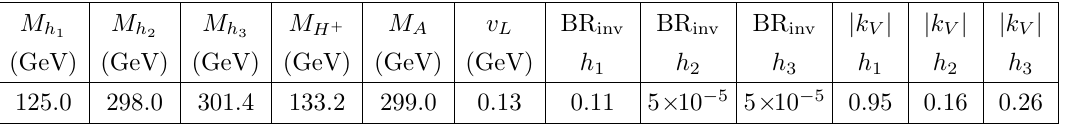
Figure 8 . Left panel: BR inv ( h 3 ) versus BR inv ( h 2 ). Right panel: the e(cid:11)ective couplings to vector bosons with respect to that of the SM, k V ( h i ) of the second and third CP even Higgs boson. Notice that these couplings are bounded due to the sum rule of eq. (5.7). In dark green the LHC constraints are imposed at 3 (cid:27) , while in yellow green (on top) is shown the result of requiring 2 (cid:27) LHC constraints.